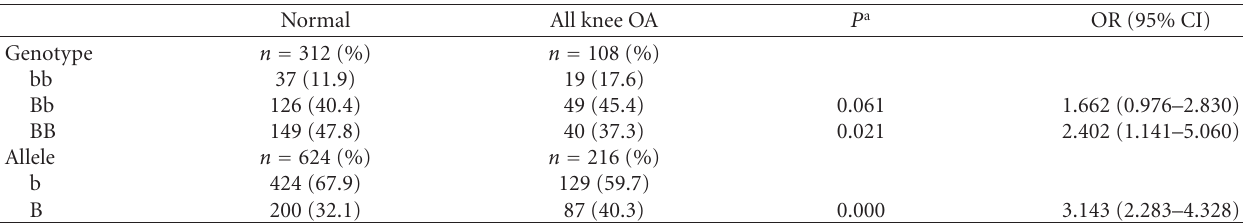
Table 3: Genotype and allele frequencies and odds ratios of MATN3 SNP6 (rs8176070) in control, knee OA cases.